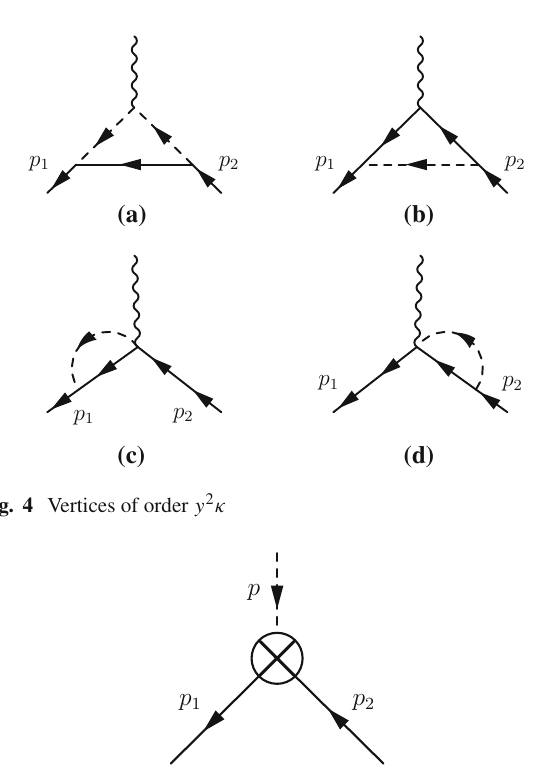
Fig. 3 Vertices of order y κ 2